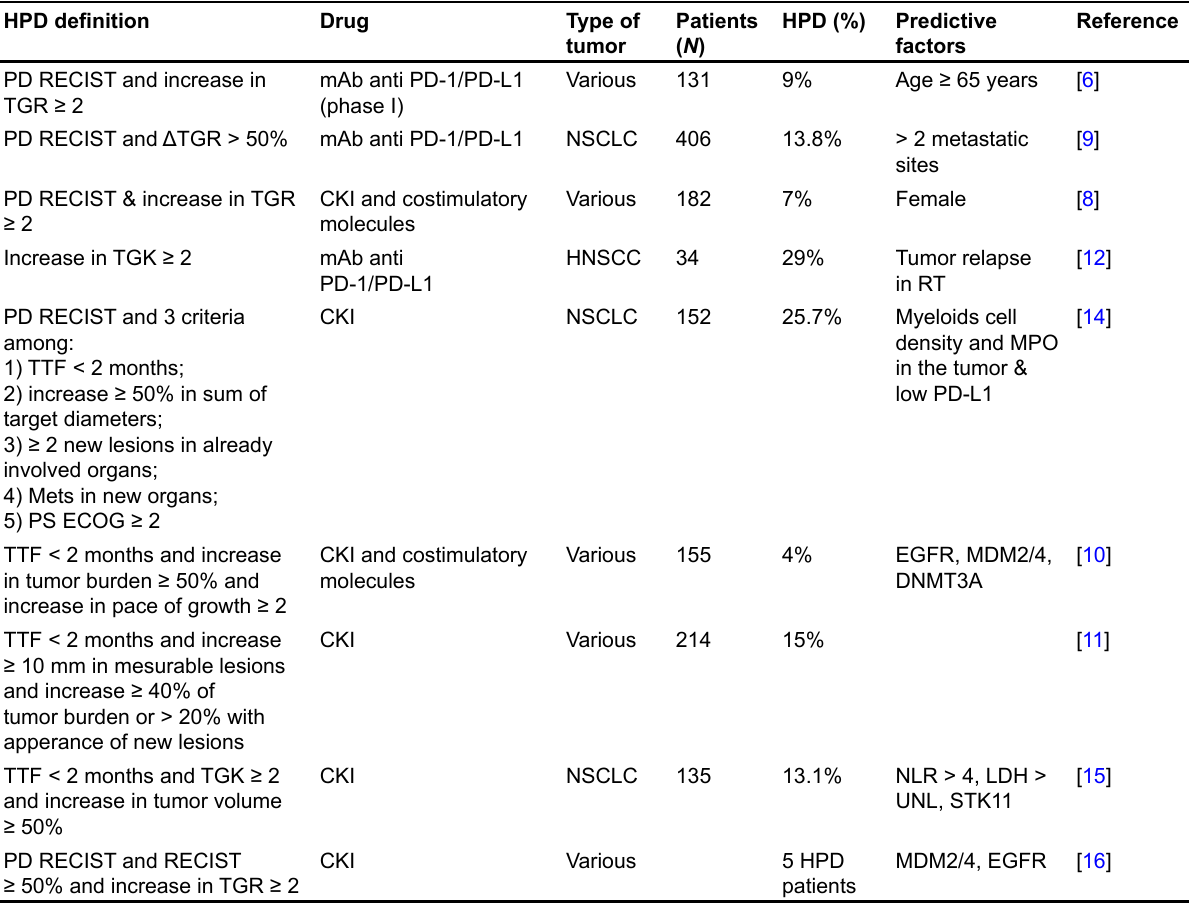
Table 1. List of the main criteria for HPD definition HPD